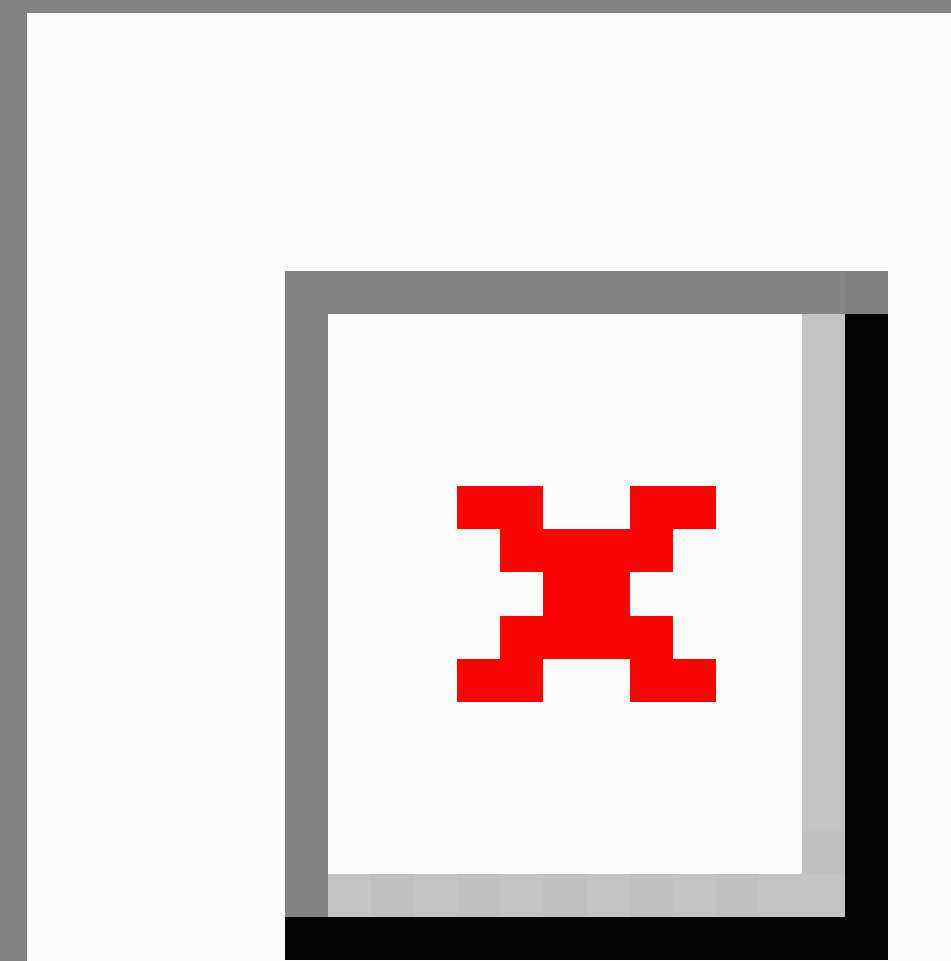
Figure 4. QC use by time of day (12-month N = 2543; 4-week N = 1257